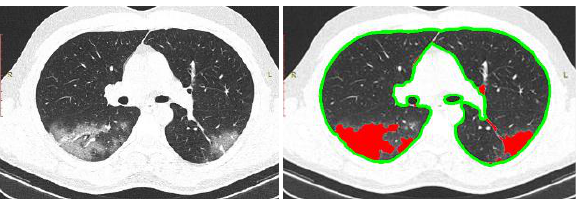
Figure 3. Segmentation of areas of the parenchyma involved. Further, with the help of Shearlet transformation various color variations are formed as shown in Fig. 4. More and less dense zones in the area of the infected parenchyma (red and yellow colors) are highlighted in relation to the air tissue of the lung